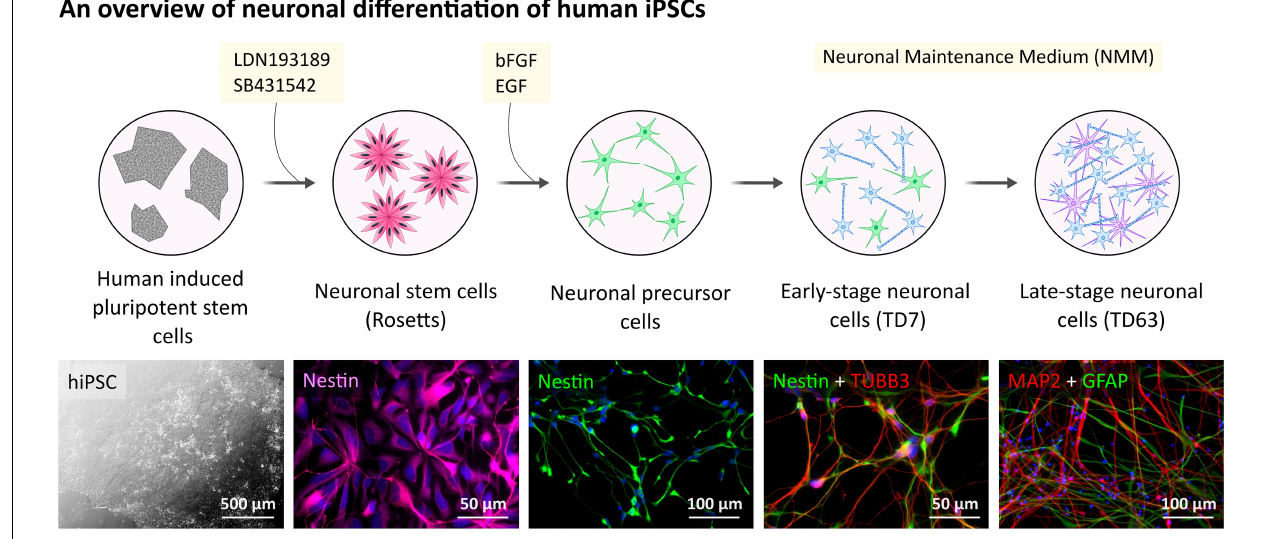
FIGURE 1 | Human hiPSC-derived neuronal cells differentiation and characterization. Outline of the general procedure of hiPSC induction and NPC differentiation toward neuronal cell cultures. Representative phase-contrast image presents hiPSC